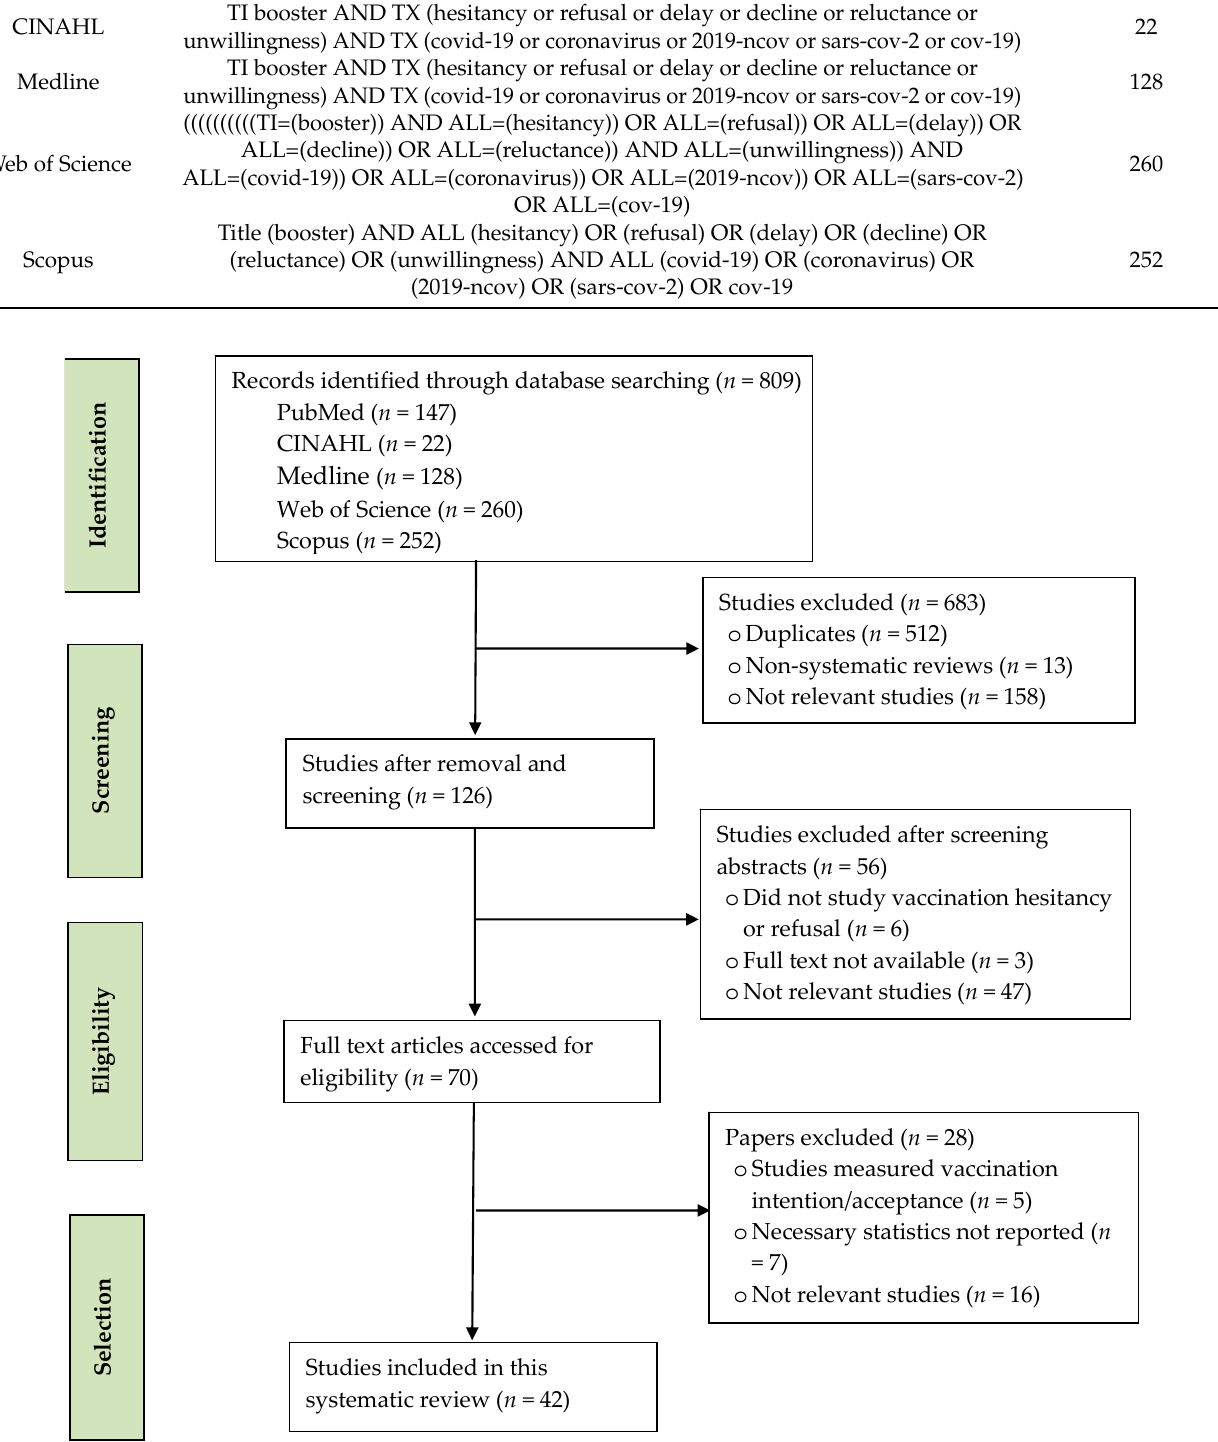
Figure 1. PRISMA flow diagram showing search strategy.